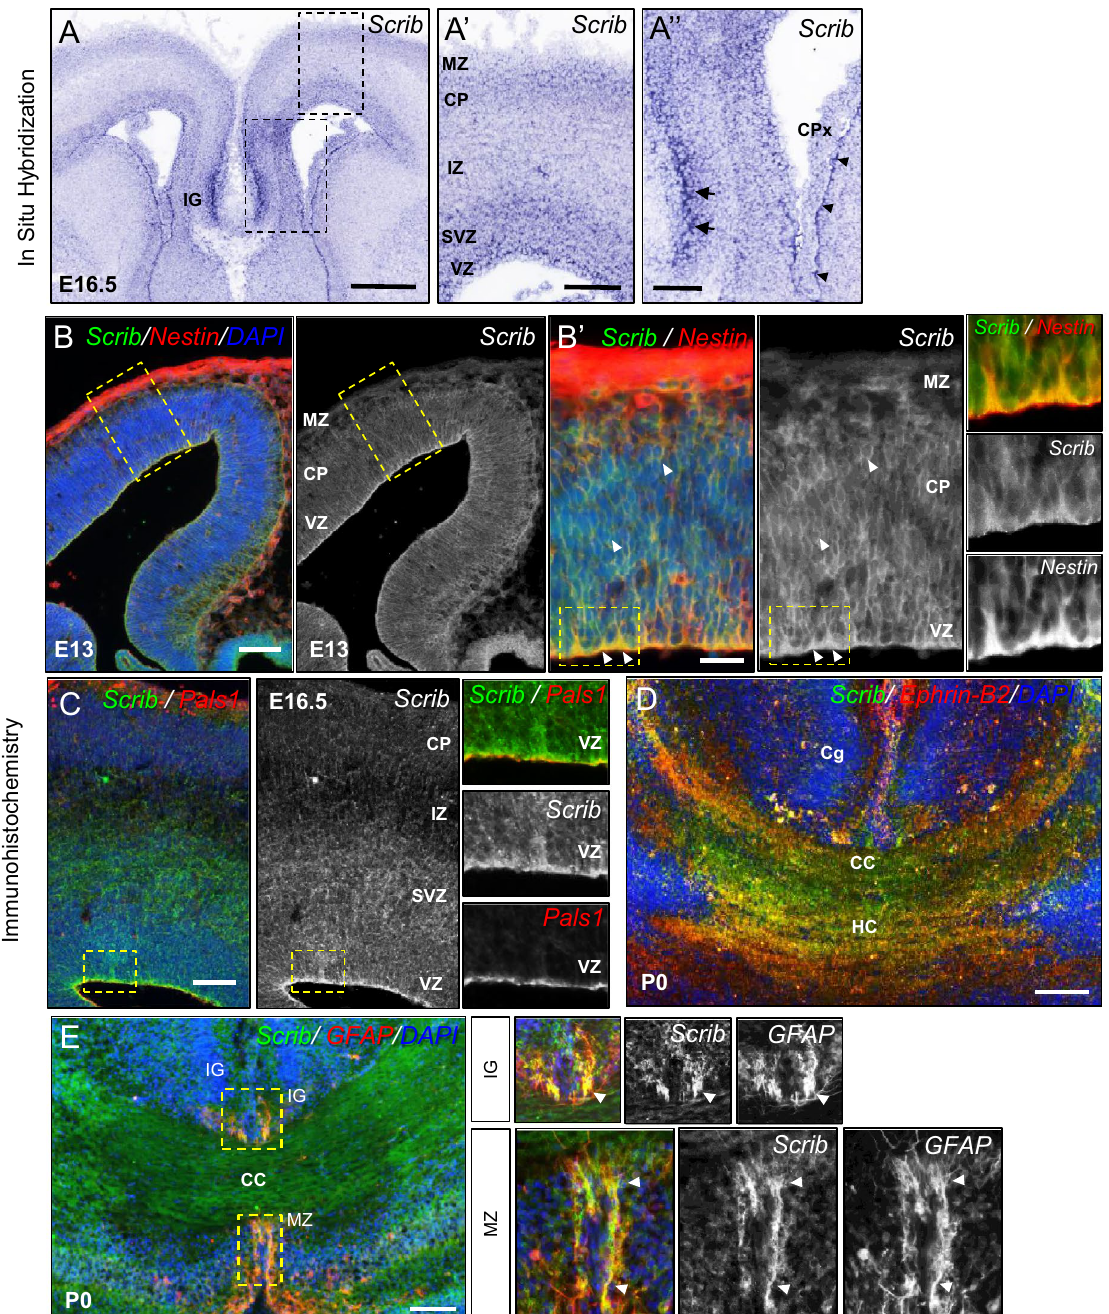
Figure 1. Scrib expression in the mouse developing forebrain. ( A-A ″ ) Representative Scrib mRNA expression pattern by ISH on E16.5 mouse embryo sections. The dashed boxes in A are magnified in ( A ′ ) and ( A ″ ). Scrib mRNA is detected on the cortical plate (CP), in the subventricular zone (SVZ), the ventricular zone (VZ) and in the indusium griseum (IG, arrows) and in ependymal cells (arrowheads) next to the choroid plexus (CPx). MZ marginal zone, IZ intermediate zone. Scale bar 0.5 mm ( A ) and 0.1 mm ( A ′ – A ″ ). ( B ) Representative Scrib (green) and Nestin (a general marker of neural progenitor cells, red) expression pattern by IF on E13 mouse embryo coronal sections. The dashed boxes in ( B ) are magnified in ( B ′ ), then within the insets. Scrib protein is detected throughout the cortical plate (CP) and is enriched in the VZ. Scale bar 0.1 mm ( B ), 0.05 mm ( B ′ ). ( C ) Representative Scrib (green) and Pals1 (an apical surface marker, red) expression pattern by IF on E16.5 mouse embryo coronal sections. The higher magnification illustrates Scrib accumulation at cell–cell contacts in the entire VZ, next to the apical marker Pals-1 (red). Scale bar 0.1 mm. ( D , E ) Representative Scrib (green) expression pattern by IF on P0 cortex ( C ), Corpus Callosum (CC) ( D ) and midline glia ( E ). Scrib labeling overlaps with Ephrin-B2 (marker of the CC, red in ( D ) but is also markedly enriched in GFAP-positive (red in E ) structures including the indusium griseum (IG) and the midline zipper (MZ). Cg is the cingulate cortex. Higher magnification for selected insets (boxed areas) illustrates strong Scrib expression in glial midline structures (see arrowheads). Scale bar 0.1 mm ( D , E